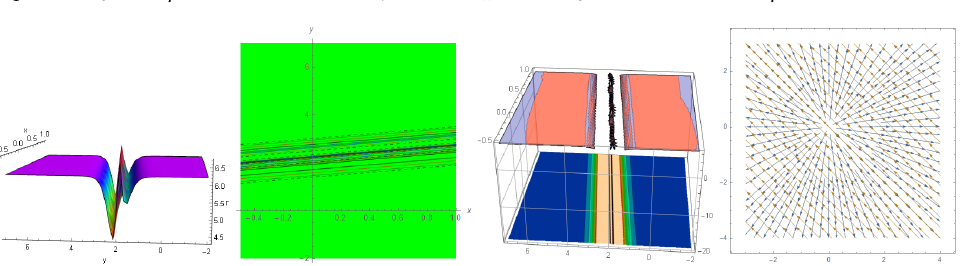
Figure 11. The sketch of Γ 5 ( x , y , t ) in Equation (31) via e 3 = 11, e 2 = 4.9, e 4 = 4, m 1 = 14, e 6 = 5, η = 1, c = 2, λ = 6, e 9 = 3.1, m 2 = 8.5, e 8 = 3, t = − 2, and ρ = 1.